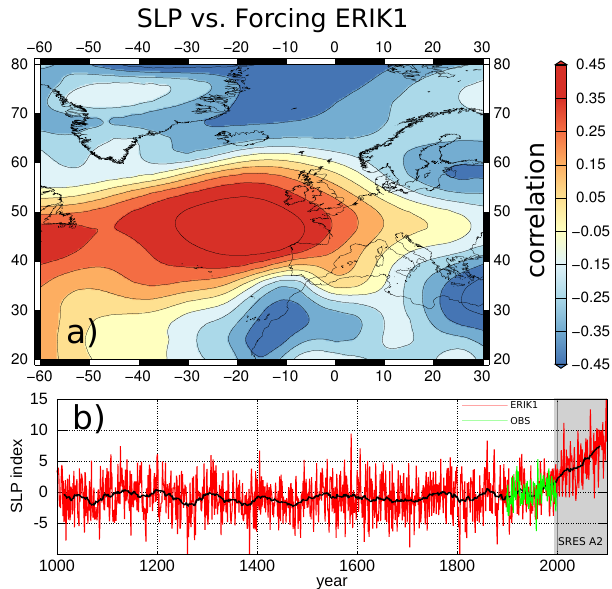
Fig. 6. Top: (a) correlation between summer (June–August) SLP and external radiative forcings in the experiment ERIK1. We show the results in the AOGCM field, since this area lies outside the sim- ulated domain by the RCM. The calculations were performed with the smoothed low-frequency series. Bottom: (b) evolution of the climate index defined as the projection of the correlation map in (a) onto the summer SLP field (red line), together with its 31-yr run- ning mean (black thick line). The projection of this pattern onto the observational dataset by Trenberth and Paolino (1980) is also shown (green line). Grey shadow indicates the time period where the prescribed forcings change from the paleosimuation to the fu- ture climate scenario SRES A2, with natural forcings kept